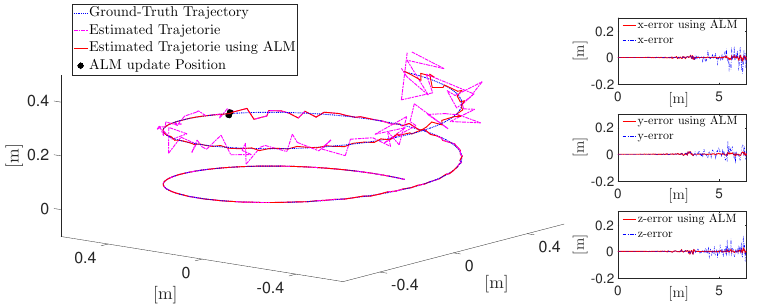
Figure 3. Experimental results for a simulation of UAV flight with drift and drift correction through artificial